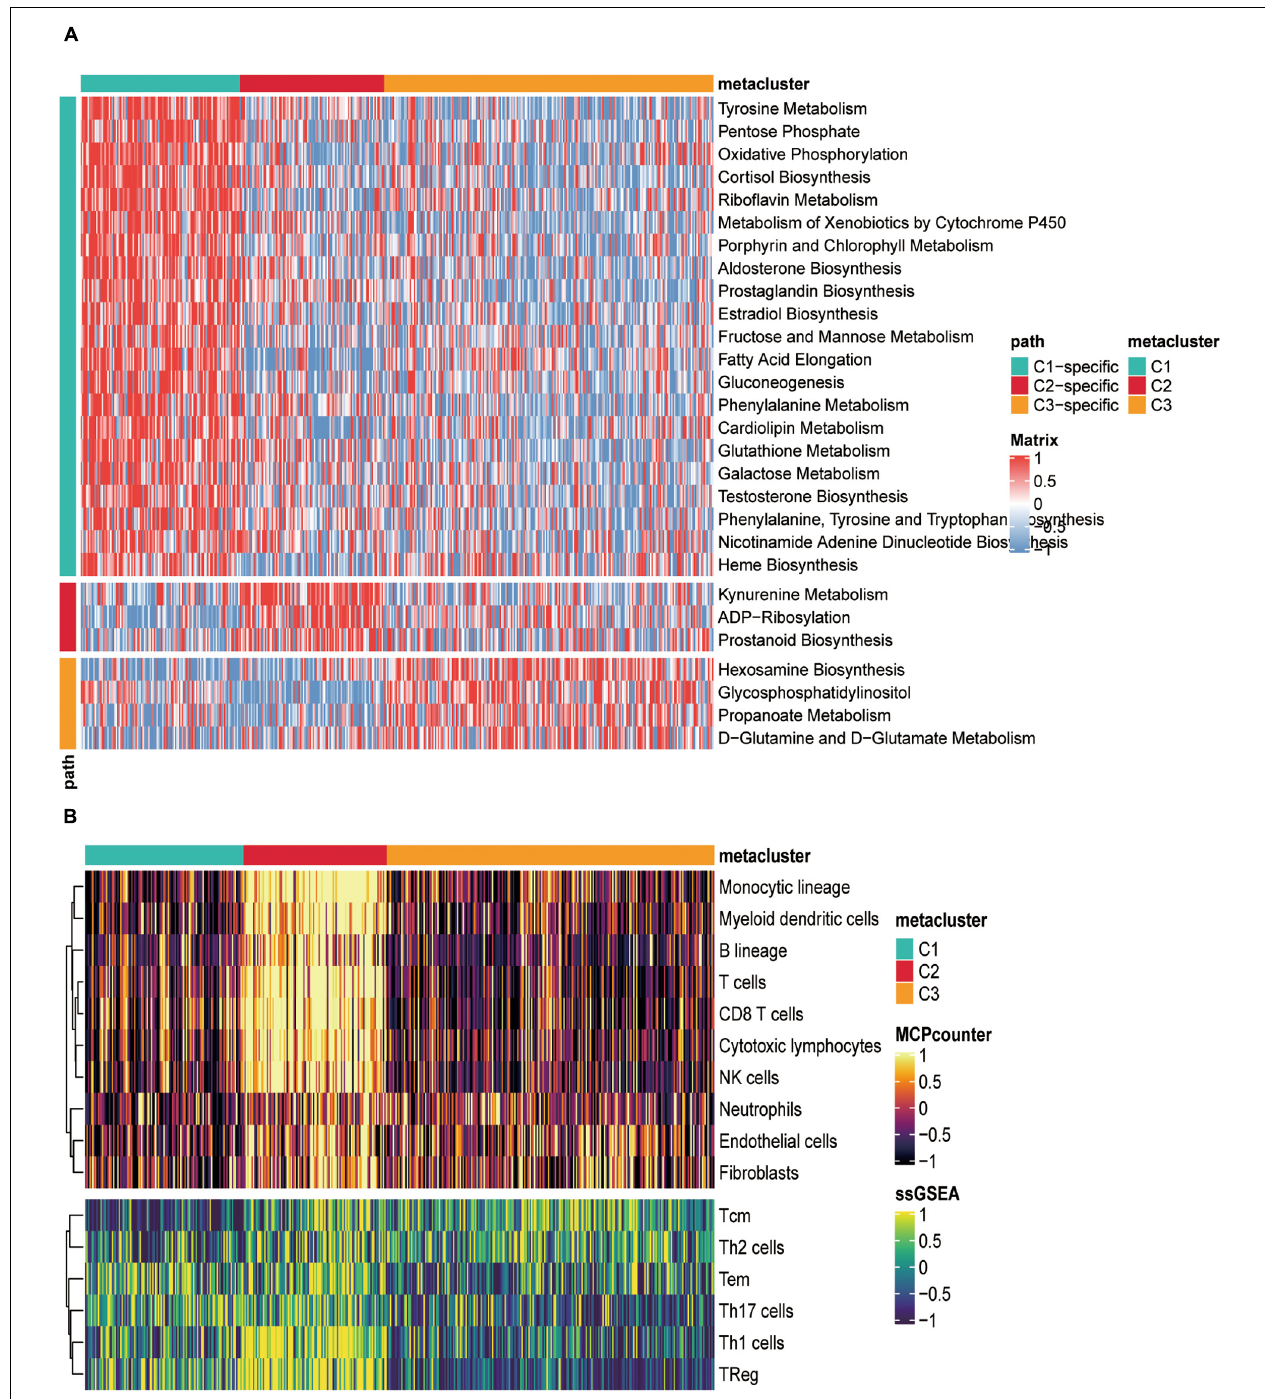
FIGURE 2 | Correlation between metabolically relevant features and immune infiltration in SKCM subtypes. (A) Heat map of specific metabolism-related signatures in three subtypes. (B) The heat map depicted the richness of immune and stromal cell populations in C1, C2, and C3 by MCPcounter and ssGSEA.